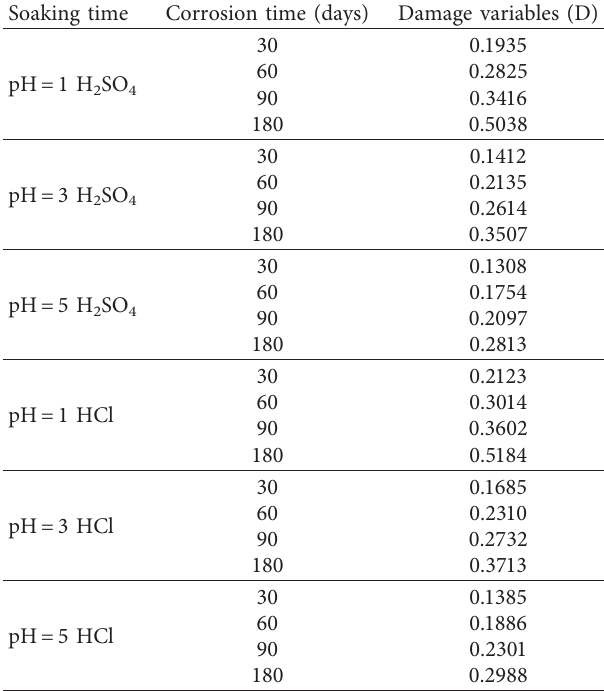
Table 6: Damage variables of the intermediate scanning layer of rock samples at different time intervals in different solutions.